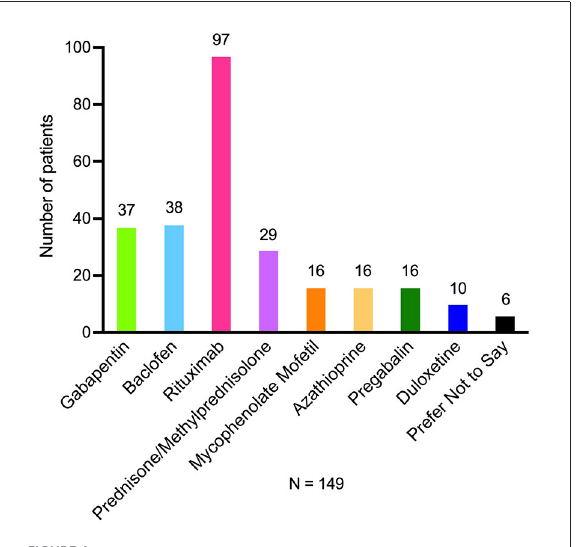
FIGURE4 Current medications being used for treatment of NMOSD symptoms. One hundred forty-nine patients reported taking